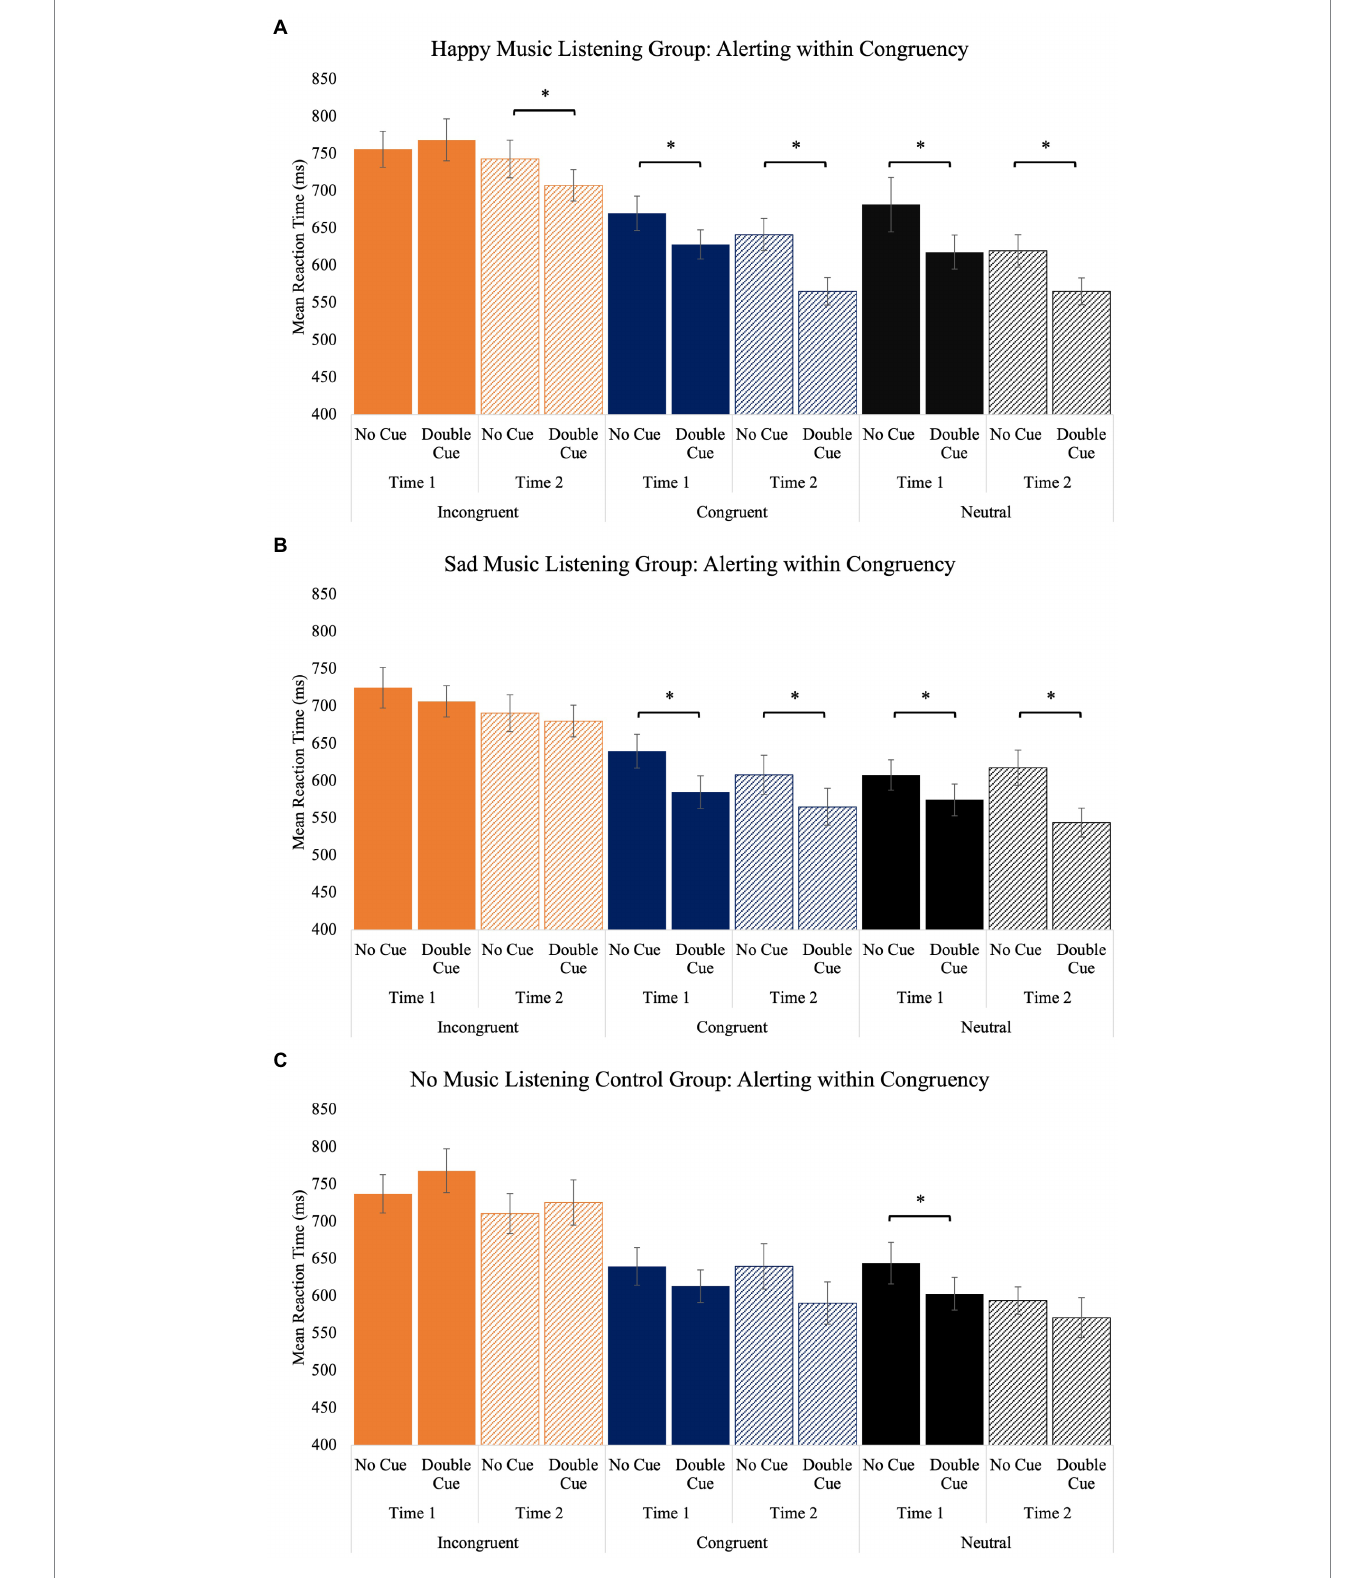
FIGURE 5 The alerting (no cue vs. double cue) effect separated by congruency (incongruent, congruent, and neutral) for the happy (A) , sad (B) , and no music (C) listening groups. Error bars represent ± 1 standard error. Note, within the control group, there is a significant difference between the no cue and double cue trials within neutral trials at time one. This difference is not marked as significant as it is in the opposite direction of the alerting effect (i.e., no cue trials were faster than double cue